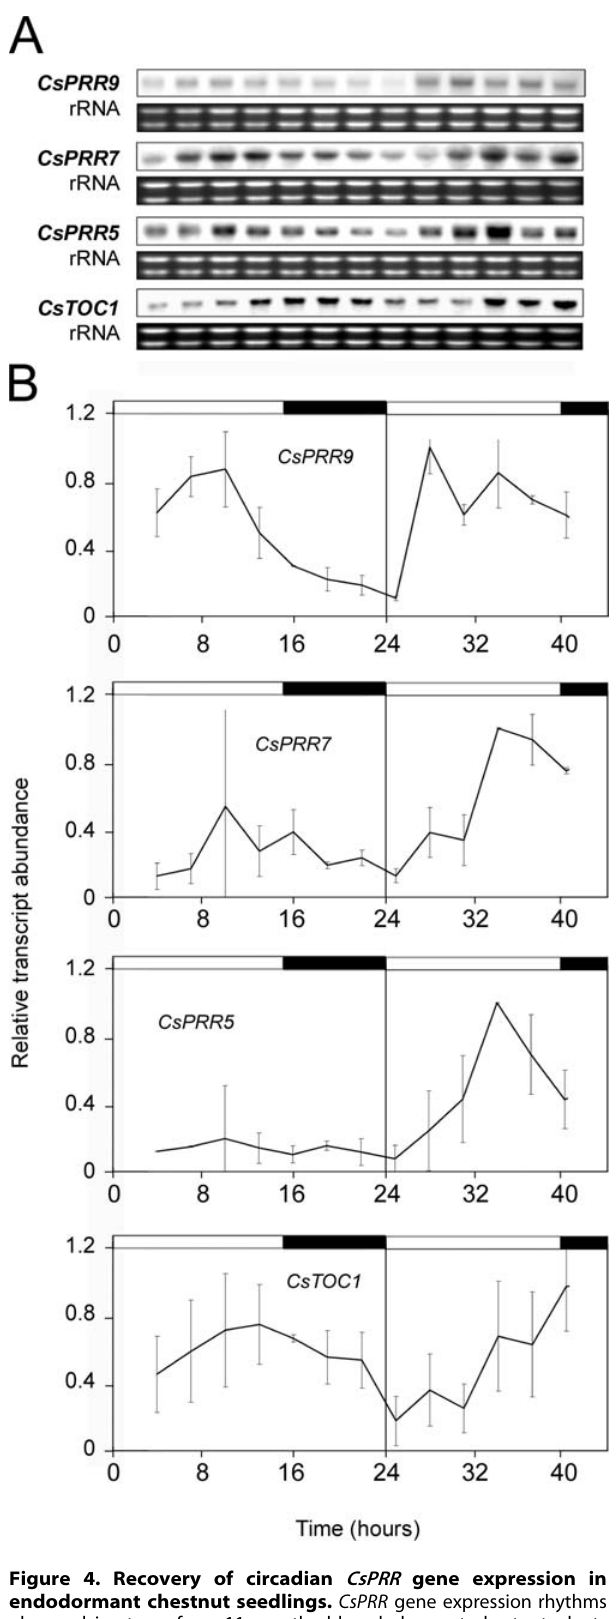
Figure 4. Recovery of circadian CsPRR gene expression in endodormant chestnut seedlings. CsPRR gene expression rhythms observed in stems from 11 month-old endodormant chestnut plants grown under natural conditions in Madrid and subsequently transferred to controlled-environment chambers under conditions of 22 u C and